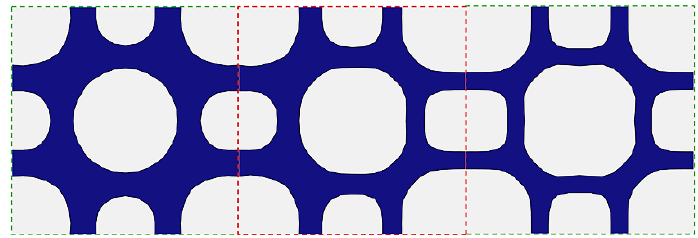
Figure 2. Transitional cell (middle) to connect two CBS (left and right) with C 1 continuity.